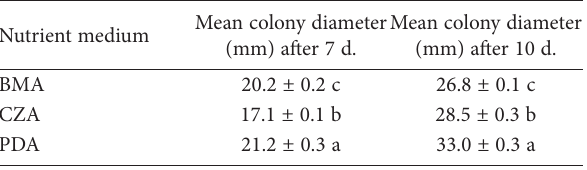
The values are means ± standard errors for three replicates. Means in each column followed by different letters are significantly different ( P ≤ 0.05; Mann–Whitney test).